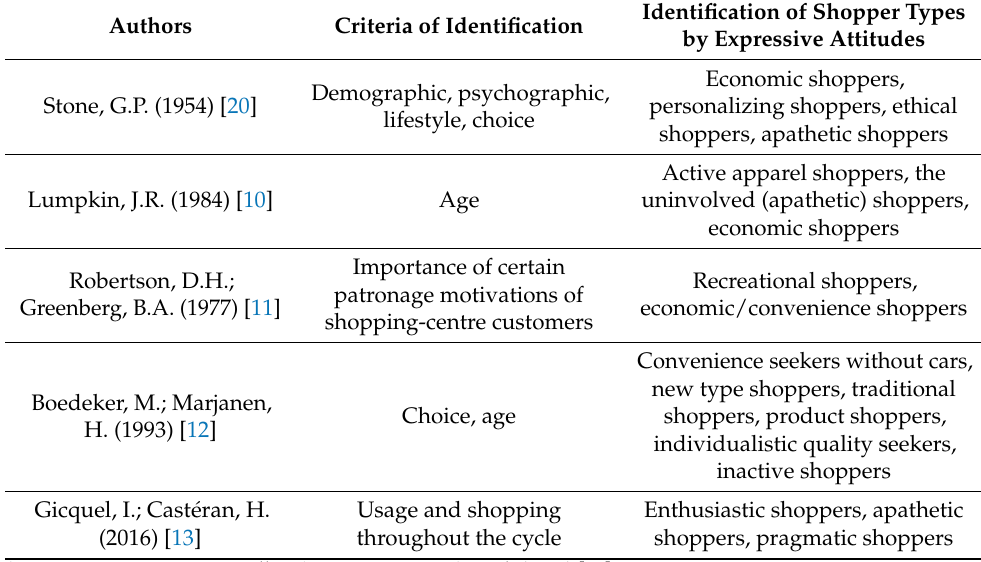
Table 1. Overview of consumer